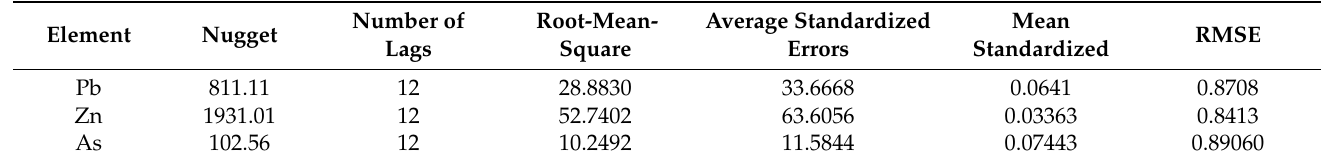
Table 3. Theoretical semi-variogram model values and error